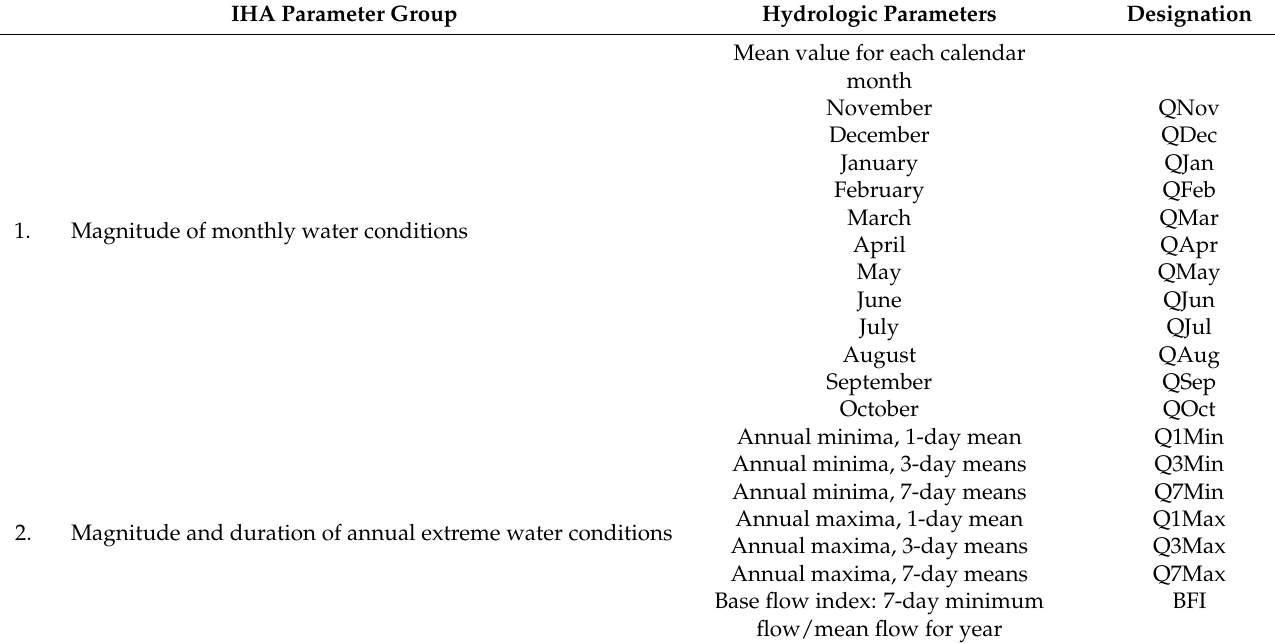
Table 1. IHA Parameters used for the assessment of the effect of the Jeziorsko dam reservoir on the flows of the Warta River in water gauge cross section Uniej ó